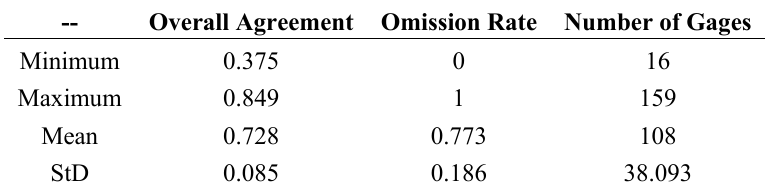
Table 3. Summary statistics on the percent agreement between satellite and in situ modeled inundation (overall agreement), percent of error due to omission (omission rate) and number of valid in situ depth estimates (# gages) given all 50 study dates. StD = Standard deviation.